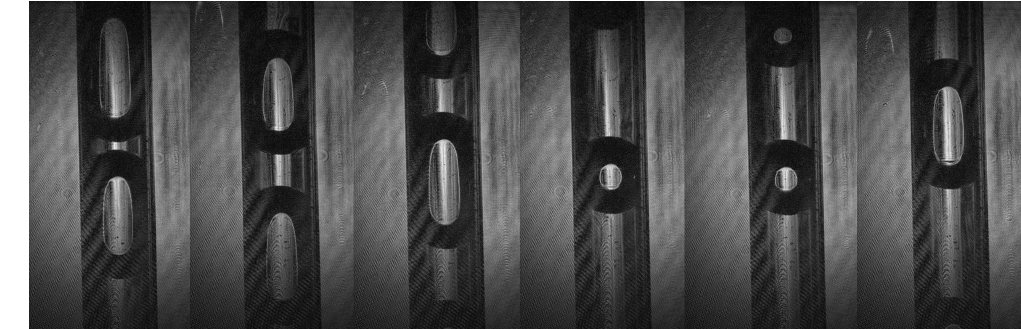
Figure 7. The reconstructed holograms from the experimental set-up shown in Fig. 6 from which the bubble position is